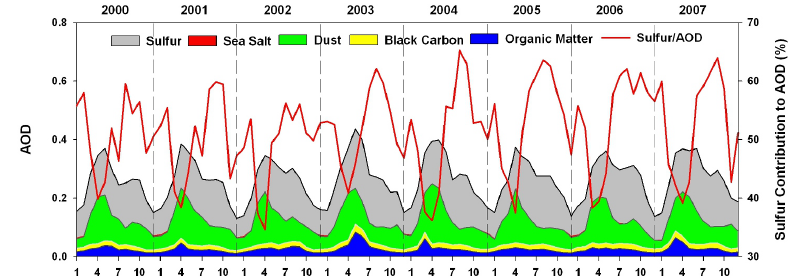
Fig. 17. Monthly variation of GOCART AOD and the contribution of sulfur to total AOD over East Asia during